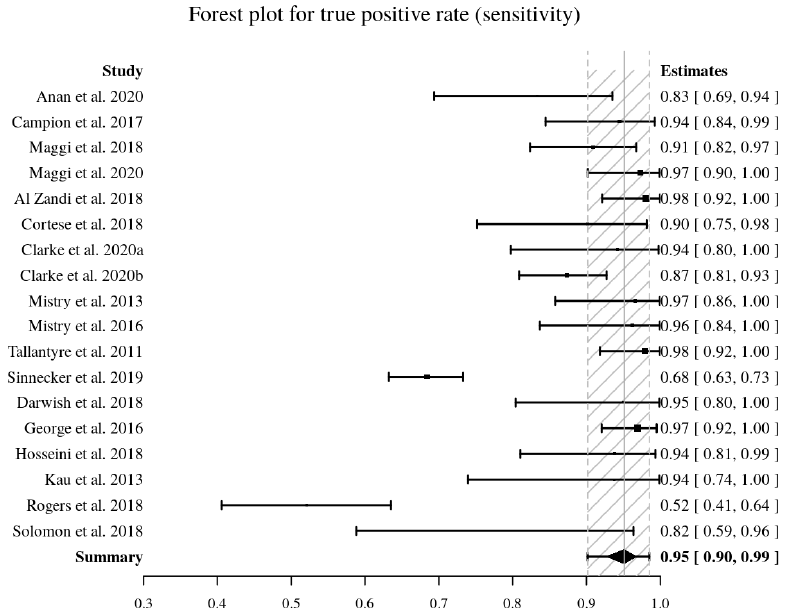
Figure 4. Forest plot of pooled sensitivity (in bold) of the central vein sign in T2*-weighted images for differentiating MS from other mimicking diseases. Sensitivity values are reported with estimated 95% confidence intervals (CIs) for each study included.